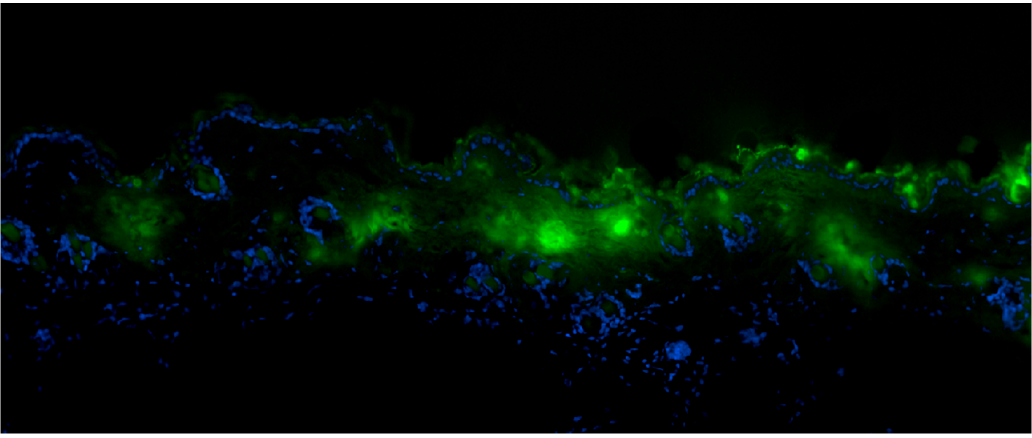
Figure 4. Sections of skin from histopathological studies that show Albumin-fluorescein isothiocyanate (FITC) penetration (green color) below the top layer ( Stratum Corneum ) of skin (stained with 4 ′ ,6-Diamidine-2 ′ -phenylindole dihydrochloride (DAPI) in blue).